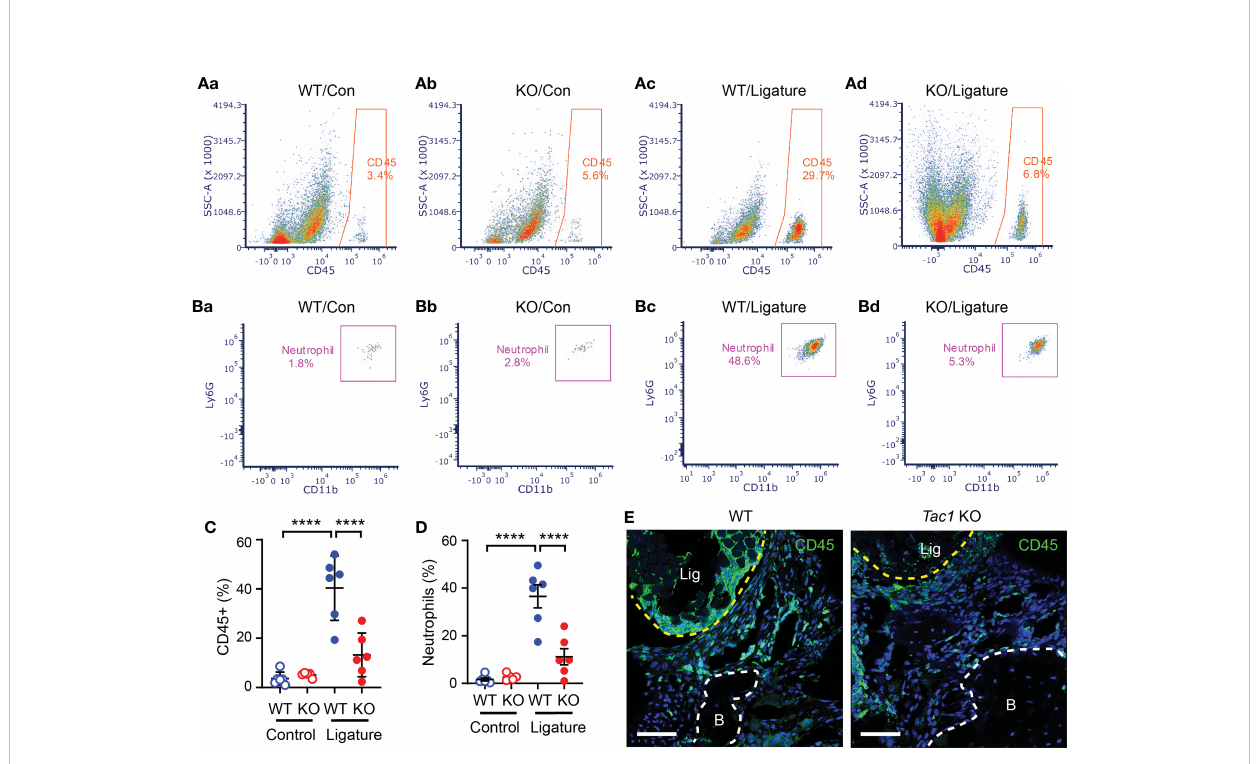
FIGURE 5 SP knockout reduces ligature-induced host responses at the site of periodontitis. (A, B) Flow cytometry was performed to identify the proportion of immune cells in single-cell suspensions from gingiva in control (Con; a-b) or ligature side (Ligature; c-d) in WT or Tac1 KO mice two weeks after ligature placement. The percentage in each plot represents the fraction of the given cells out of live, single cells in each sample. Examples of total CD45+ leukocytes (A) and neutrophils (B) in WT/control, KO/control, WT/ligature, and KO/ligature groups are shown. (C, D) Proportions of CD45+ or neutrophils in live, single cells in each sample are plotted. ****p <0.0001 in Sidak post hoc tests following one-way ANOVA. N=6 per group. (E) Immunohistochemical labeling of CD45 in a periodontium under ligature (Lig; yellow dotted line) in WT or Tac1 KO mice two weeks after placing the ligature. Scale bar, 50 µm. B, alveolar bone; Lig,